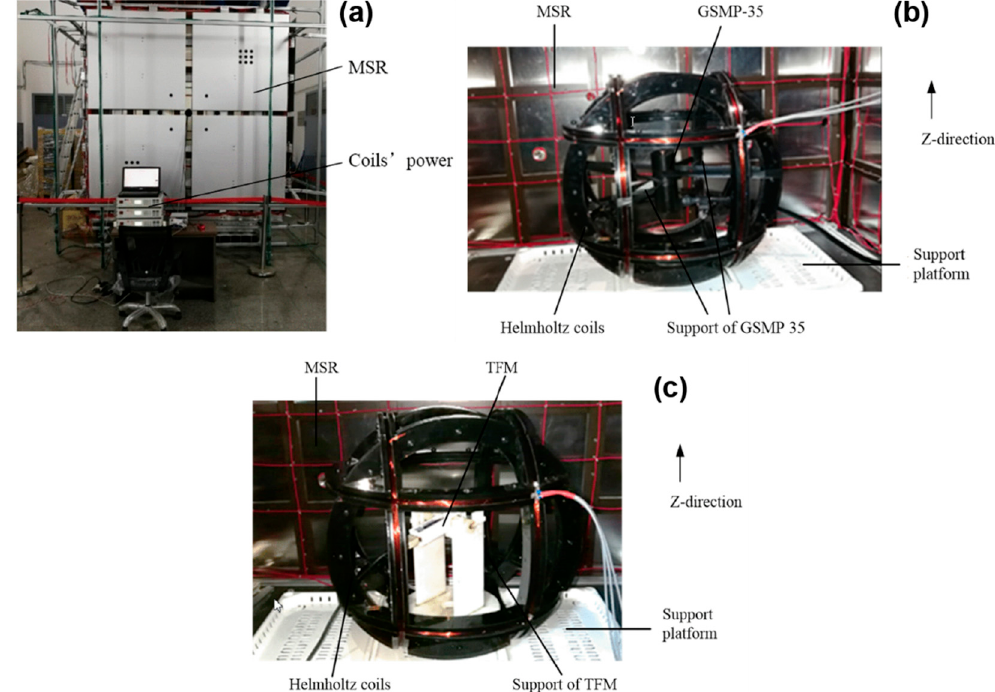
Figure 7. Experimental picture of the device for calibration of TFMs with MSR and TUMC: ( a ) Test platform; ( b ) Calibration of TUMC; ( c ) Calibration of TFM.